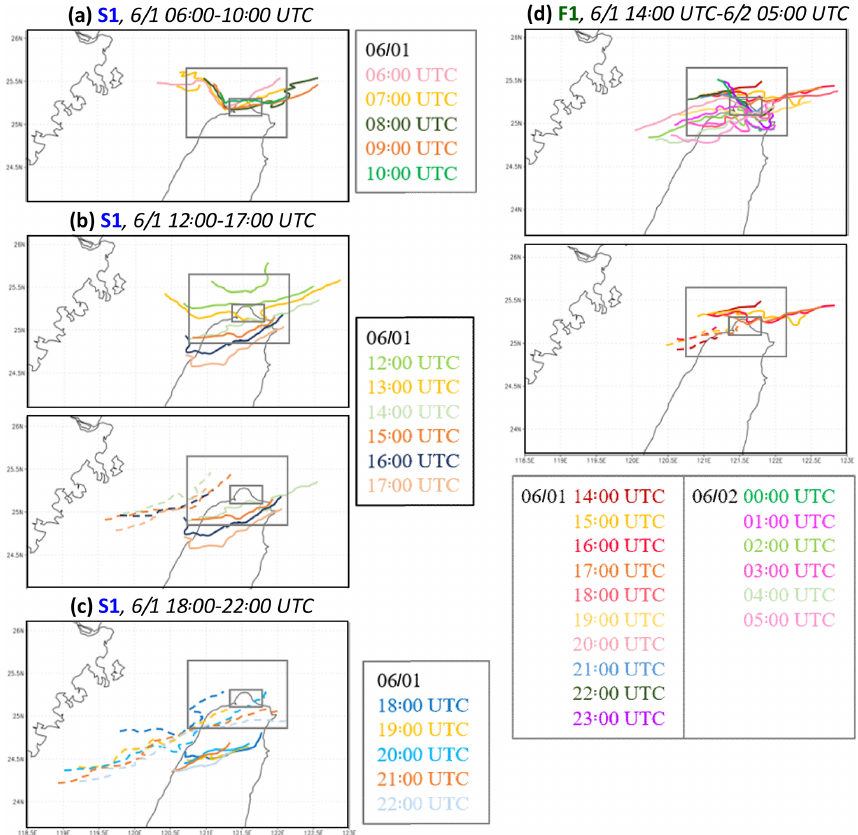
Figure 13. Model-simulated surface rainband positions (at leading edge) around northern Taiwan at 1h intervals during (a) 06:00– 10:00UTC, (b) 12:00–17:00UTC, and (c) 18:00–22:00UTC on 1 June in the S1 experiment, and (d) from 14:00UTC on 1 June to 05:00UTC on 2 June 2017 in the F1 experiment, respectively. In (c) and the second panels of (b) , (d) dashed lines represent other rainbands nearby during the same time